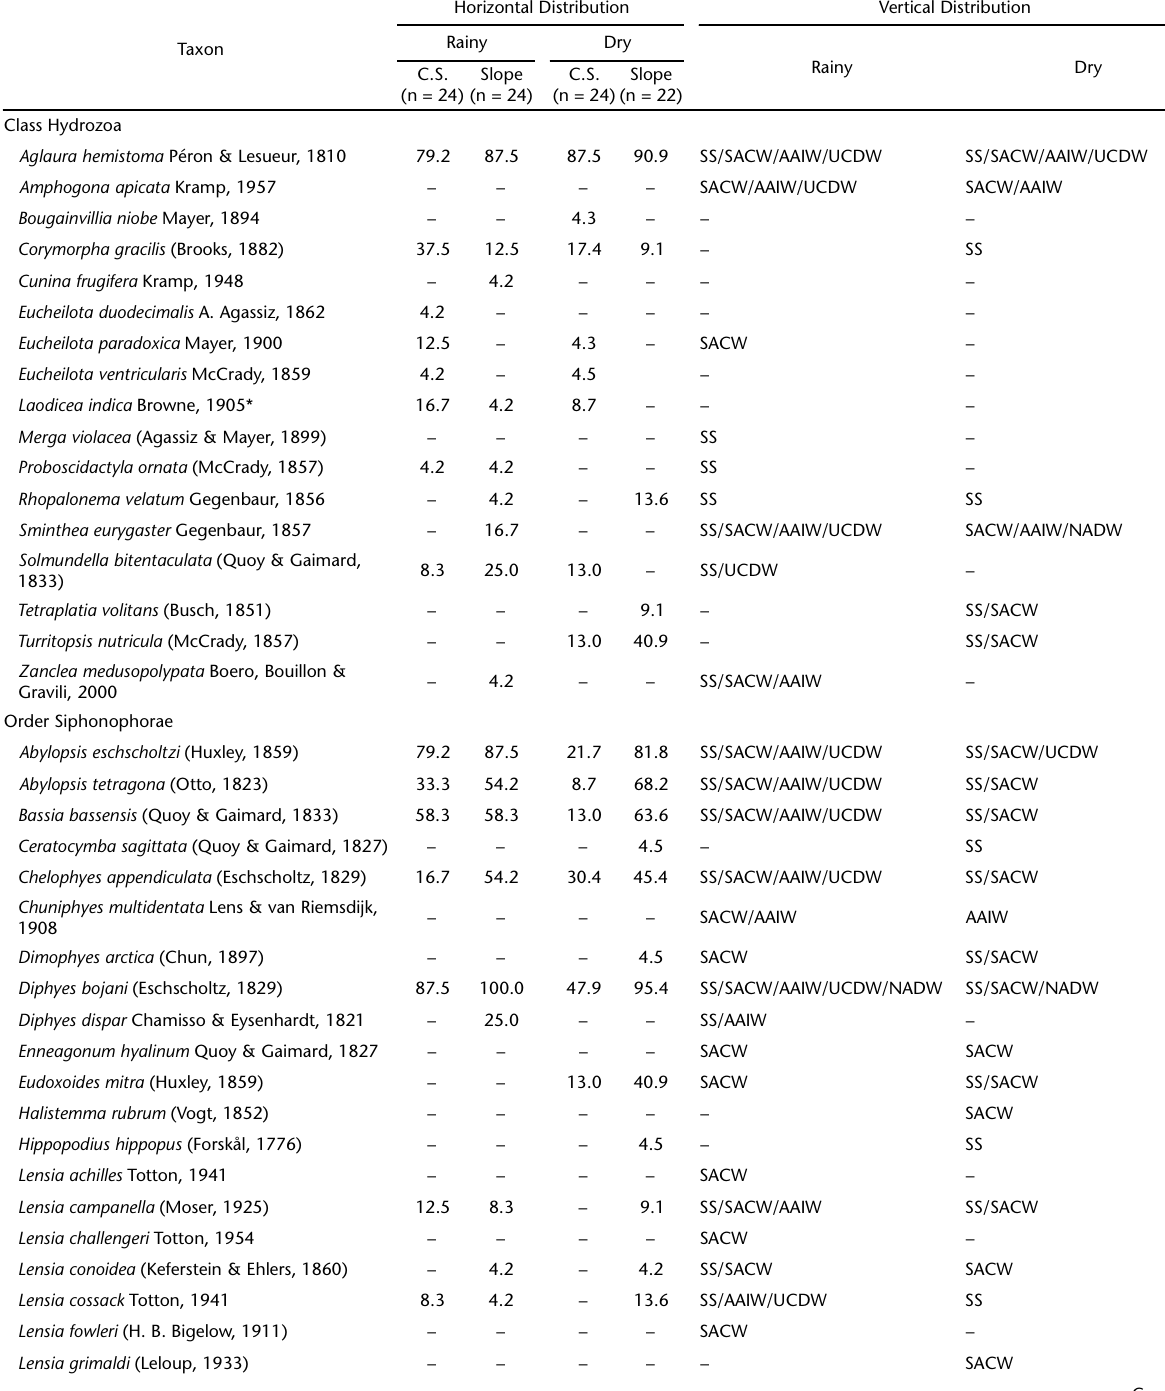
Table II. Frequency (%) of mesozooplankton species over the continental shelf (C.S.) and slope and vertical distribution in the Campos Basin, central Brazilian coast, during the rainy and dry seasons. SS – Subsurface Water, SACW – South Atlantic Central Water, AAIW – Antarctic Intermediate Water, UCDW – Upper Circumpolar Deep Water, NADW – North Atlantic Deep